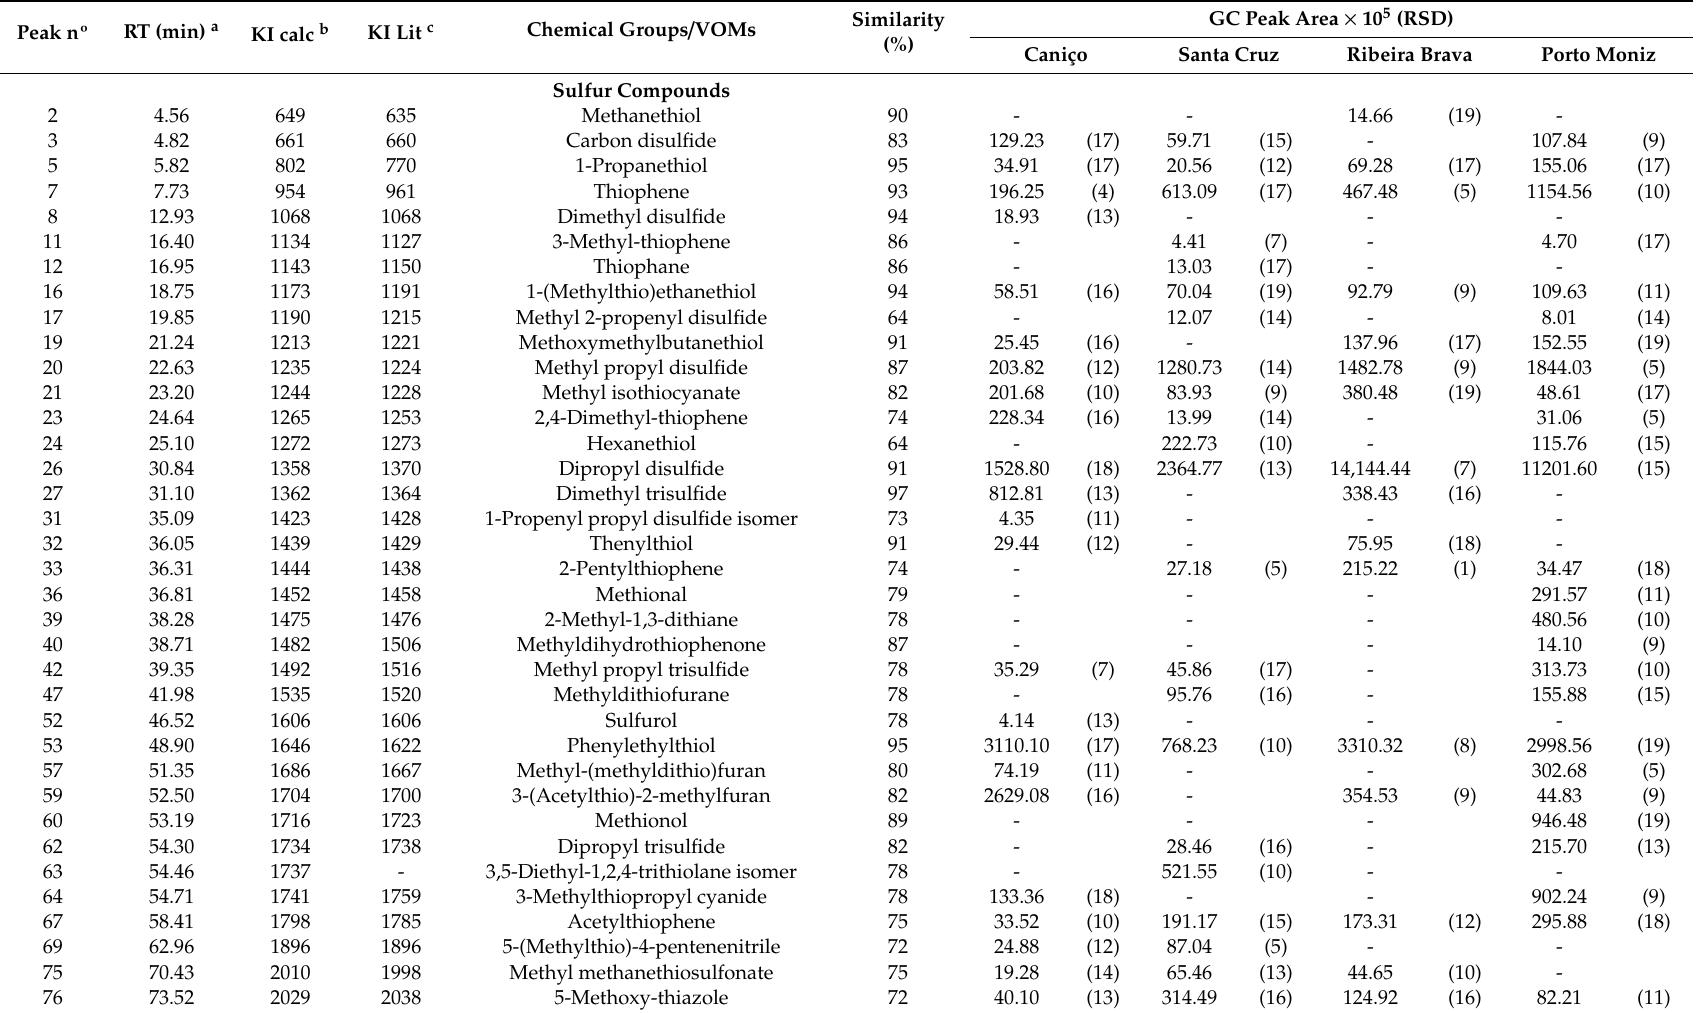
Table 2. The volatomic signature of Allium cepa L. from di ff erent geographic regions using headspace solid-phase microextraction (HS-SPME /